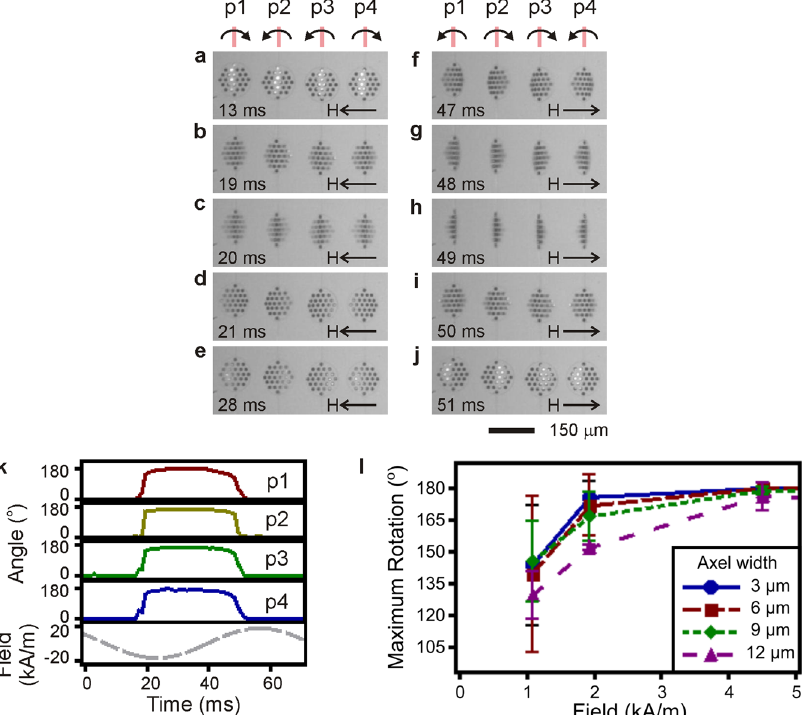
Fig. 2 Microscopy time-series and rotation measurements of membrane cells. Sequence of images taken at the times indicated, showing a – e the forward and f – j the reverse rotation of four paddles (p1 – p4) on identical 3- µ m-wide axles during the application of a 15 Hz, 17.3 kA/m sinusoidal fi eld. k Time-plot of individual paddle rotations and applied fi eld for the cycle shown in a – j . l Effect of axle width and fi eld amplitude on the maximum paddle rotation (15 Hz fi eld). Data points are the average of three paddles in separate cells, error bars show standard